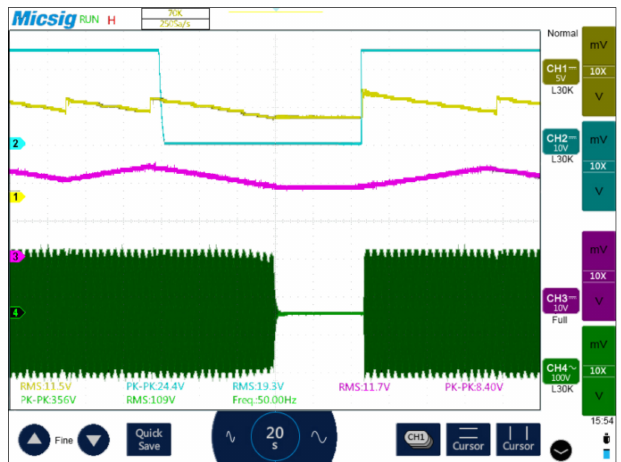
Figure 11. The operation of SCAWI-PV inverter during a line disruption (Yellow—input voltage of the inverter, Blue—12 V input source voltage, Purple—Voltage across the supercapacitor bank, Green—Output voltage of the